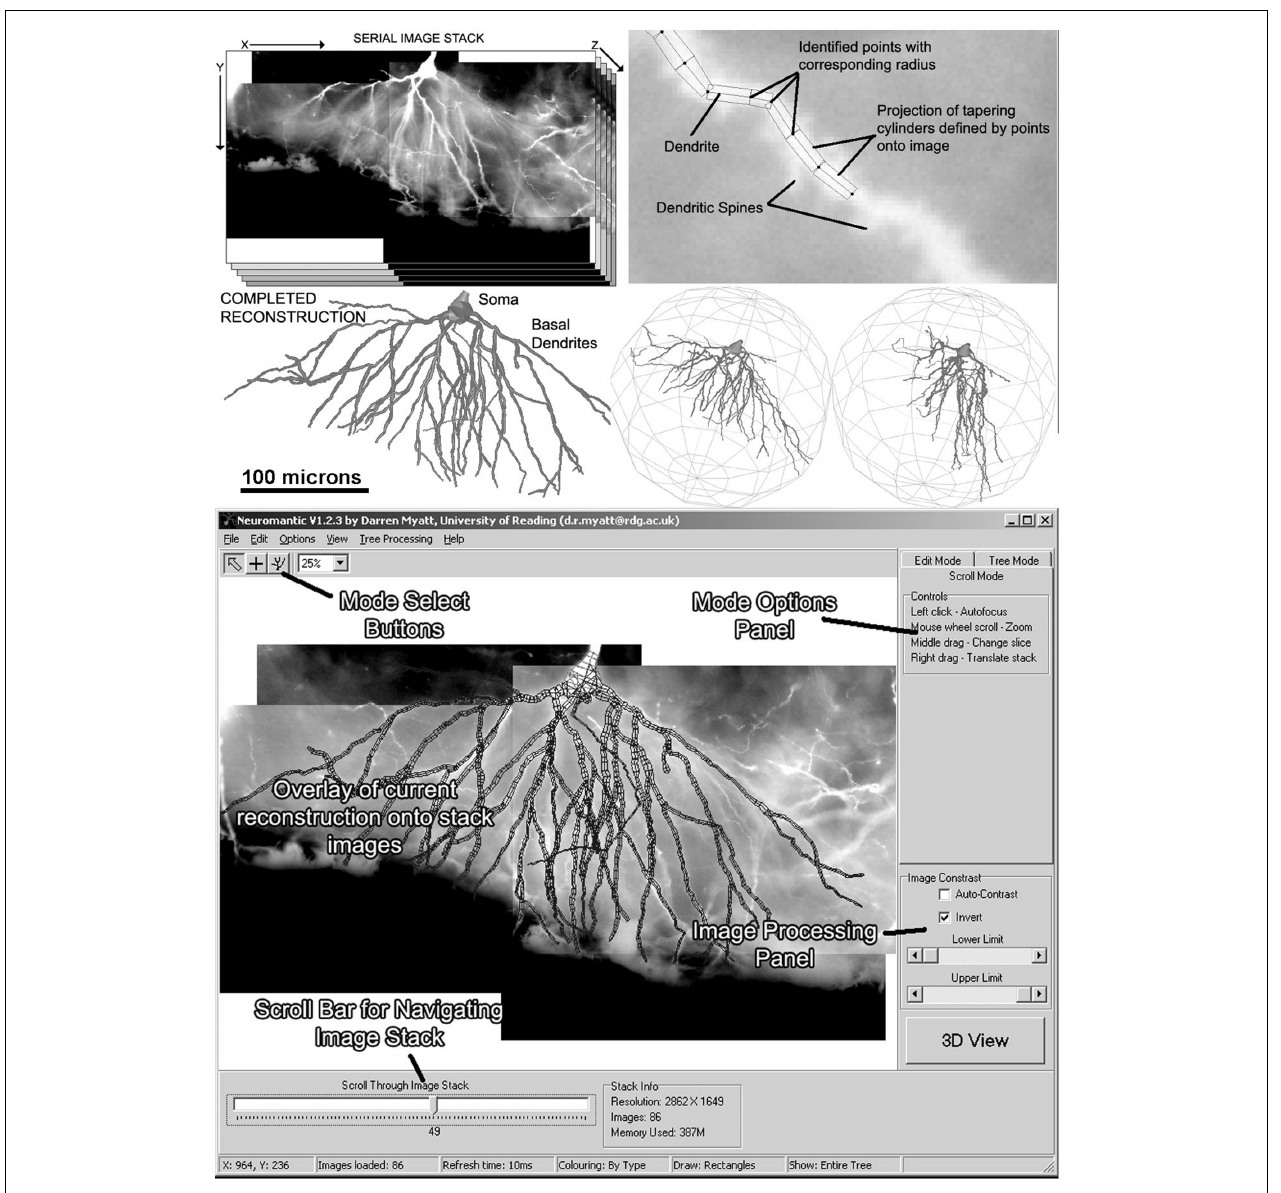
bottom panel displays the application interface with labels indicating the main features. Most of the functionality available via the interface is also replicated in mouse and keyboard shortcuts for